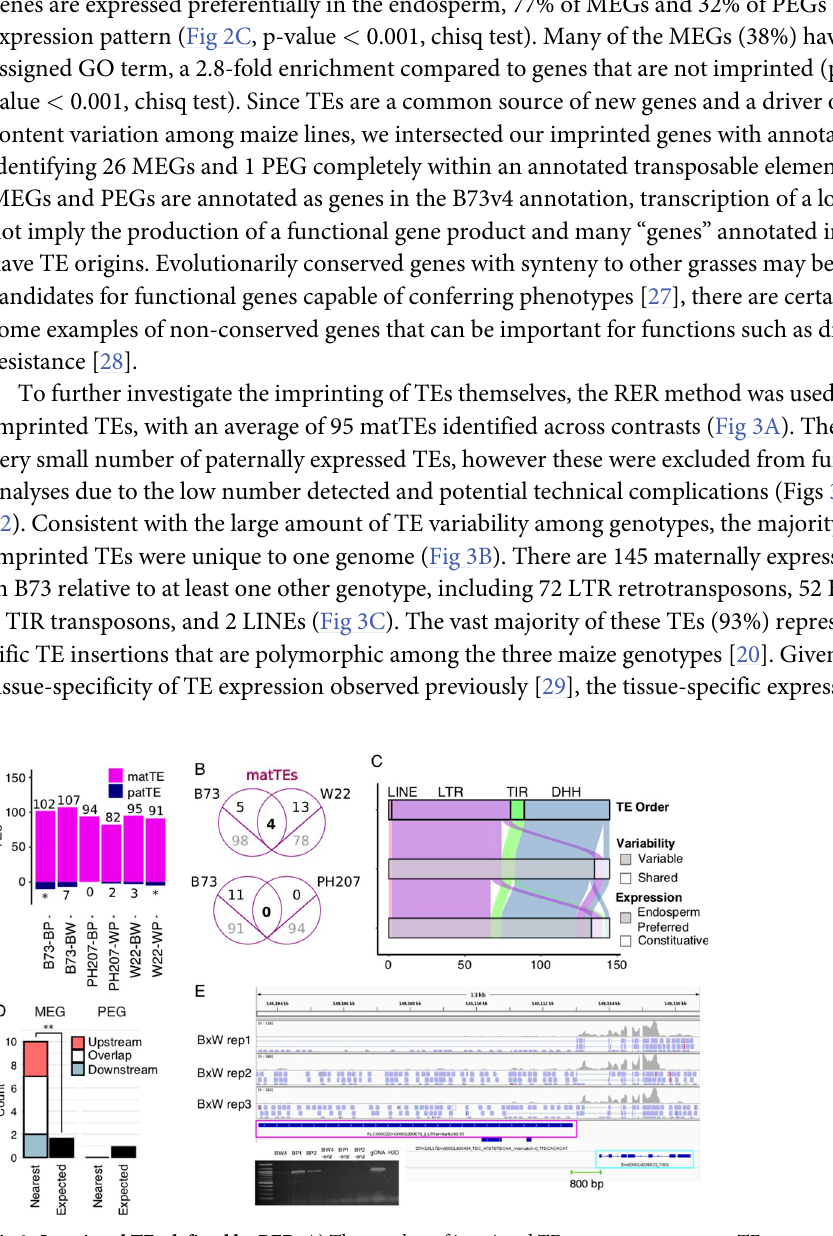
Fig 3. Imprinted TEs defined by RER. A) The number of imprinted TEs across contrasts. matTEs are marked in magenta and paternally expressed TEs are marked in navy. Asterisks denote contrasts where paternally expressed TEs could not be defined (S2 Fig). B) The overlap between matTEs across pairwise contrasts. TEs that are shared between genotypes that could be assessed for imprinting are shown in black above the line while imprinted TEs unique to one genome are shown in gray below the line. C. Features of matTEs in B73. TE orders are abbreviated: DHH = Helitron, TIR = terminal inverted repeat transposon, LTR = LTR retrotransposon, and LINE = long interspersed nuclear element. TE variability is defined by prior work (Anderson et al. 2019). Endosperm-preferred expression is described by patterns across development (S5 Fig). D) Imprinting status of closest gene to matTEs. Expected number is based on the number of MEGs and PEGs that were assessed for imprinting. �� p-value < 0.001 (binomial test) E) IGV view showing a representative example of reads aligning to a matTE near a MEG. Reads are colored by the strand of alignments, where blue = forward strand. Green line shows primer positions for RT-PCR, with positive result shown in gel